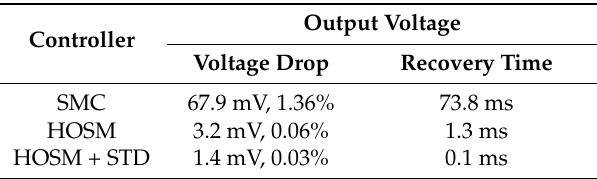
Table 4. Input voltage perturbation analysis results.